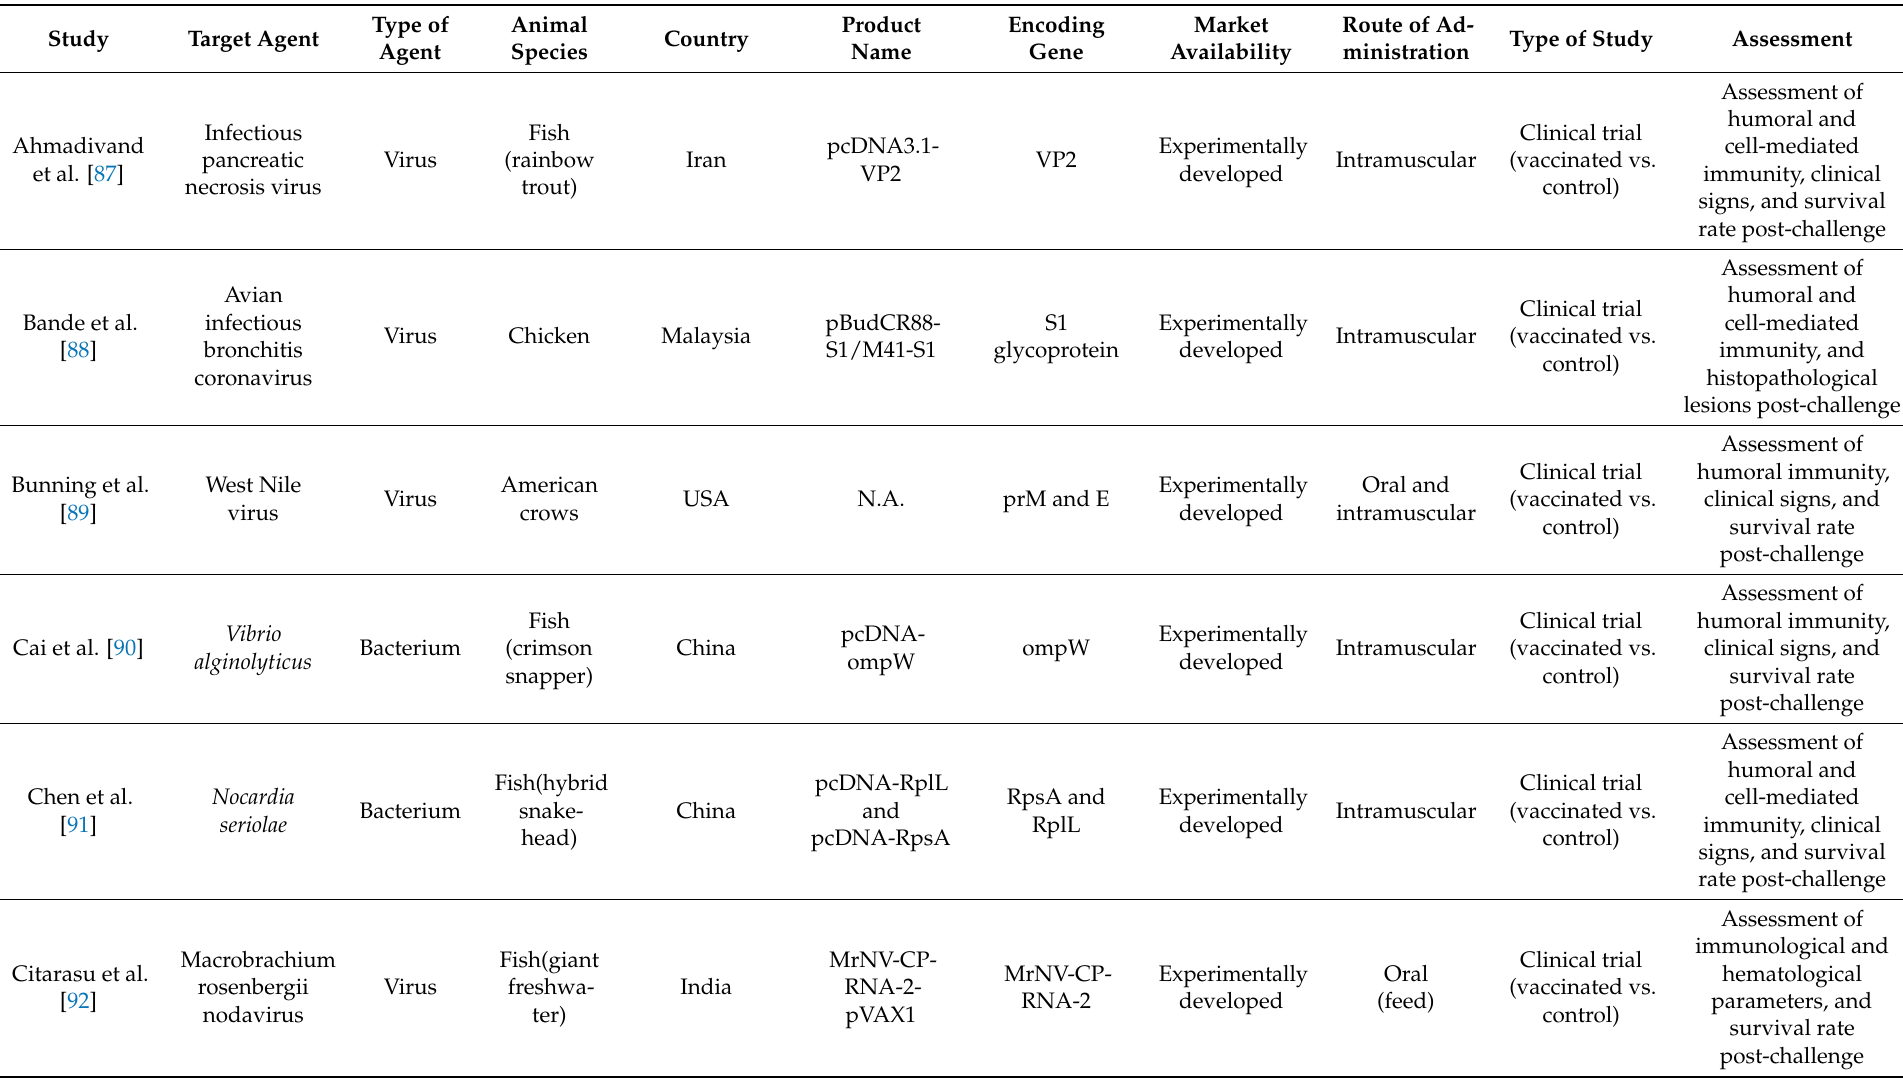
Table 3. Overview of the studies included in the qualitative synthesis retrieved from the search on DNA